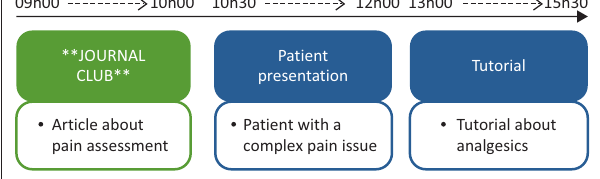
FIGURE 2: An example of the timed schedule and linked content within a typical clinical teaching